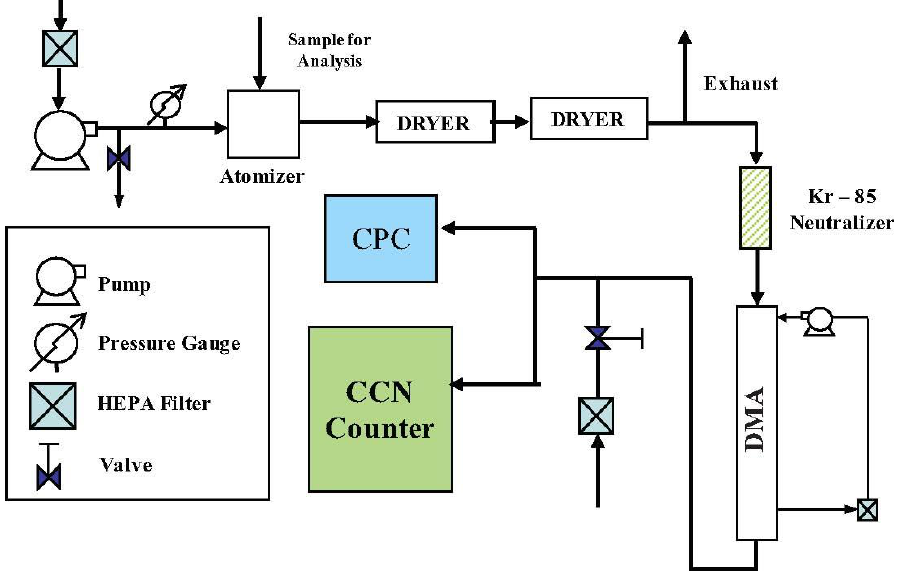
Figure 2. Experimental setup for characterizing size-resolved Cloud Condensation Nuclei activity of samples analyzed in this